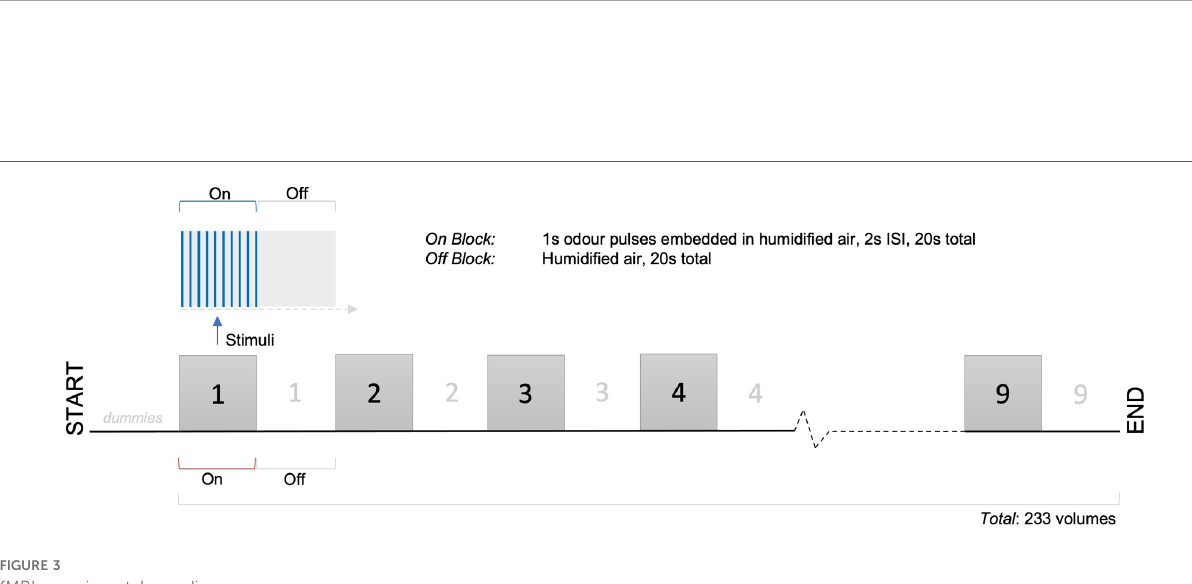
FIGURE 2 Diagram showing: ( A ) standardised placement of spreader grafts between septum and upper lateral cartilage; ( B ) standardised placement of columellar strut between medial crura of lower lateral cartilage. ULC, upper lateral cartilage; LLC, lower lateral cartilage.